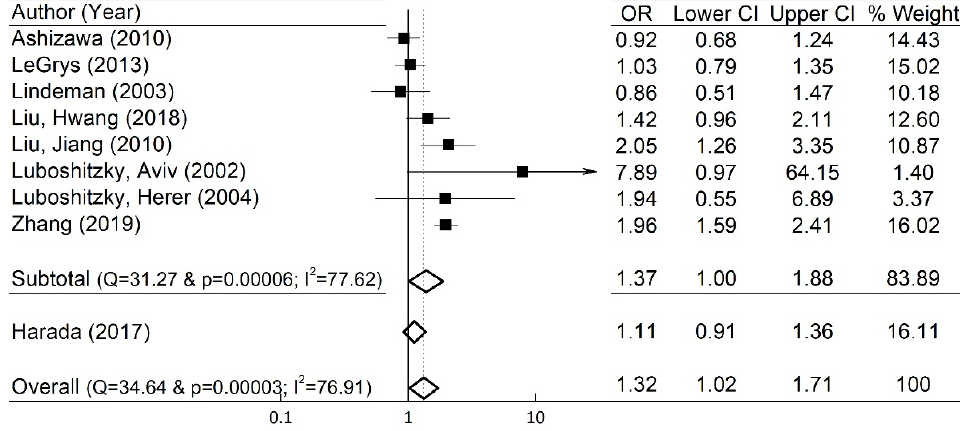
) represent (cid:51)